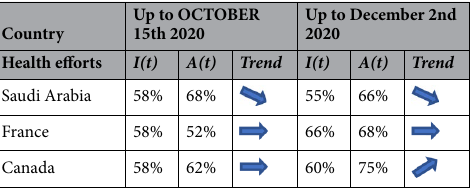
Table 5. CPM model health efforts peaks and moving trends. Health efforts I(t) means the I(t) containment efforts. Health efforts A(t) implies hospitalisation